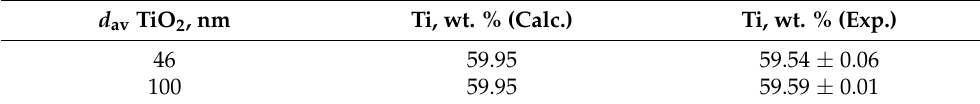
Table 1. Results of elemental analysis of TiO 2 nanopowders. d av TiO 2 , nm Ti, wt. %